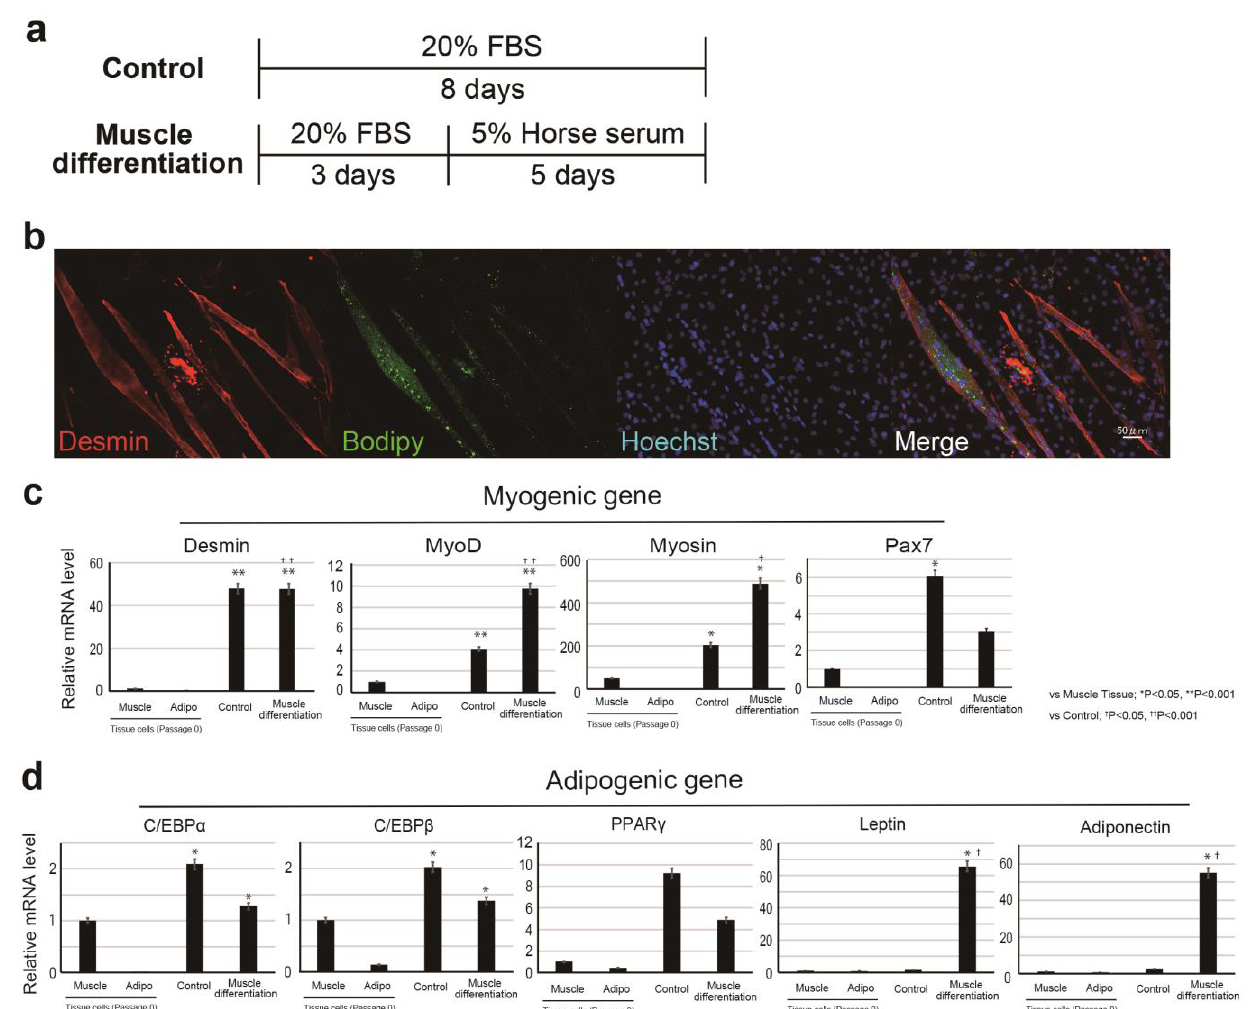
Figure 2. Differentiation of CD29+ cells to myogenic linage. ( a ) Scheme of CD29+ cell differentiation. ( b ) Immunohisto- chemical analysis of induced cell differentiation. Desmin (a marker of muscle cells) is shown in red; BODIPY (indicating lipid droplets) is shown in green; and Hoechst-stained nuclei are shown in blue. ( c , d ) Relative expression of myogenic genes: DESMIN , MYOD , MYOSIN , PAX7 , and adipogenic genes: CEBPα , CEBPβ , PPARγ , LEPTIN and ADIPONECTIN in CD29 cells by real-time RT-PCR (muscle: CD29+ cells from muscle tissue cultured without passage, adipo; CD29+ cells from adipo tissue cultured without passage, normal; non-induced cells, muscle differentiation; muscle-induced cells). Using one-way ANOVA with a Bonferroni correction, * p < 0.05 or ** p < 0.001; compared with muscle cells, † p < 0.05, †† p < 0.001; compared with control. ( n = 4).